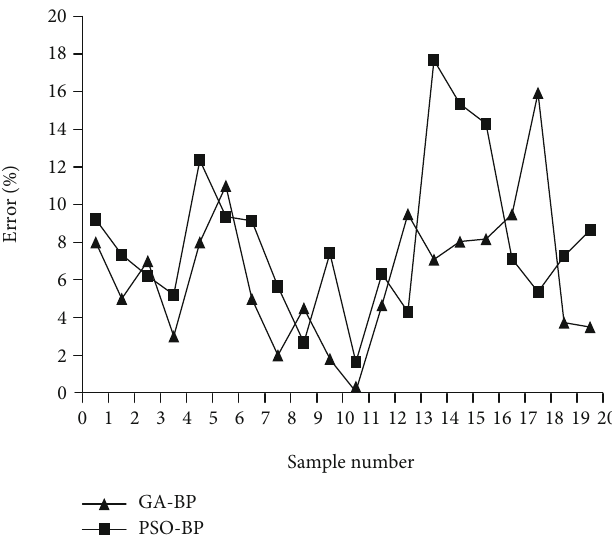
Figure 7: House price prediction error of PSO-BP and